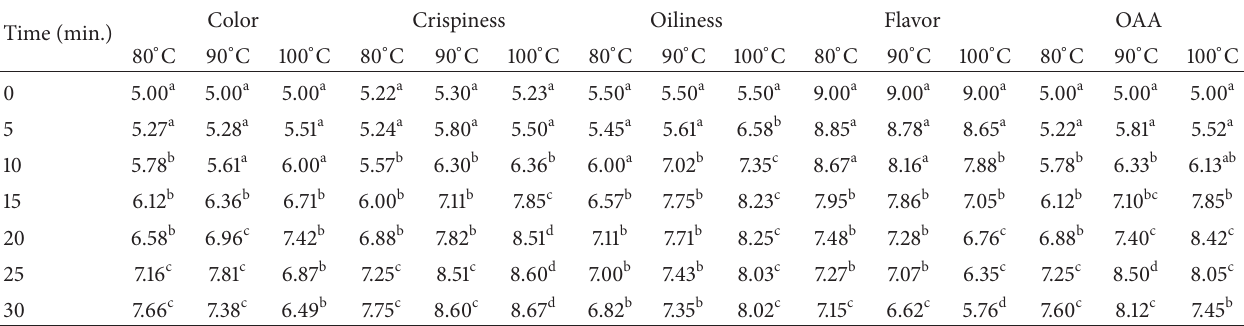
Table 3: Sensory acceptability of jackfruit chips as effect of different frying temperatures. Time